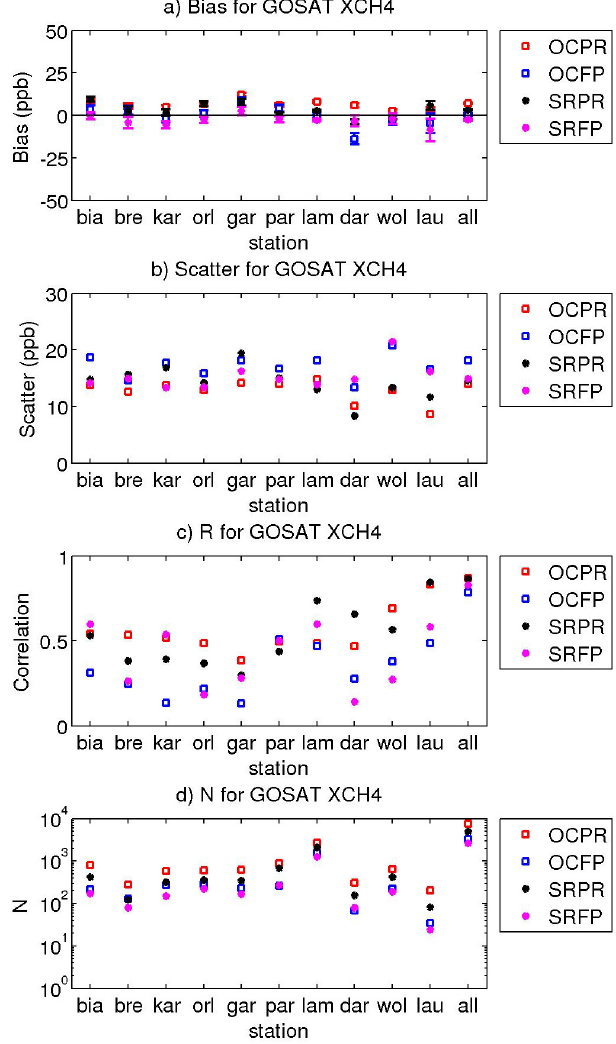
Figure 12. GOSAT XCH 4 bias (a) , scatter (b) , correlation (c) and number of data pairs (d) , for all individual TCCON stations and all data